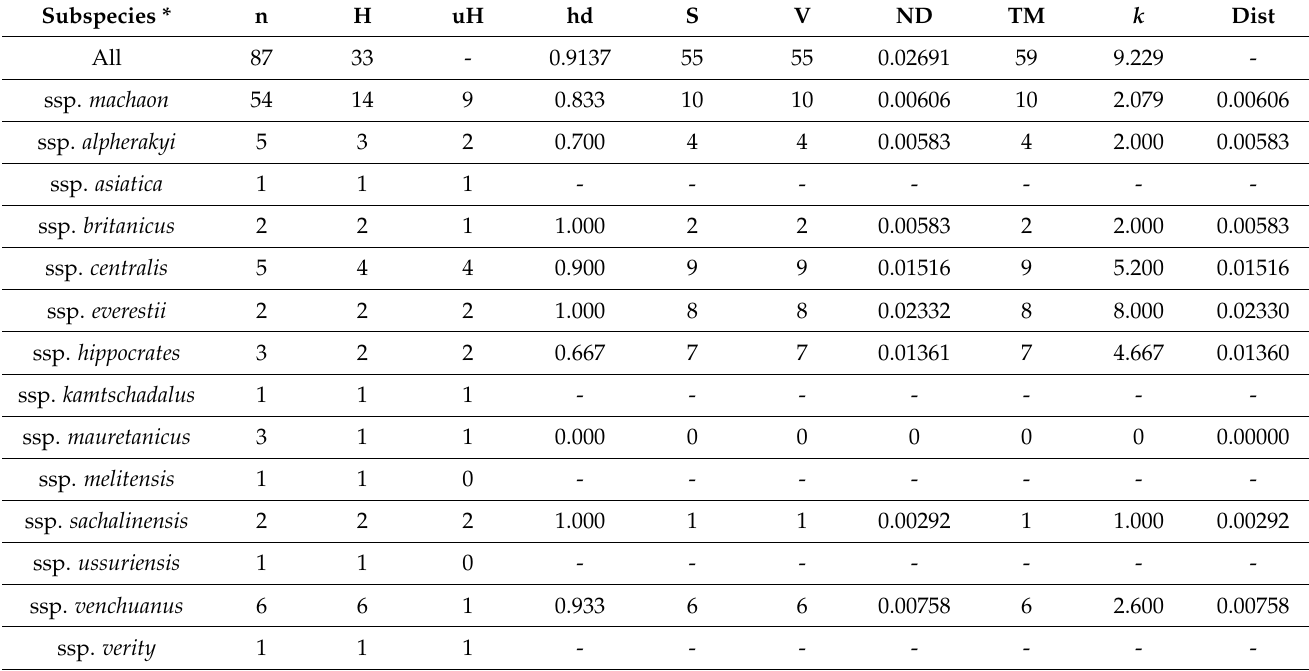
Table 2. Standard genetic indices and average pairwise genetic distance of 16S rDNA